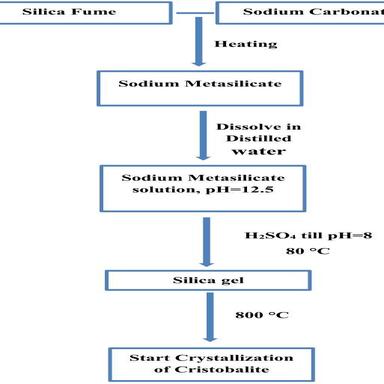
Flow chart of the procedure for preparing sodium silicate, amorphous nanosilica, and nanocristobalite.